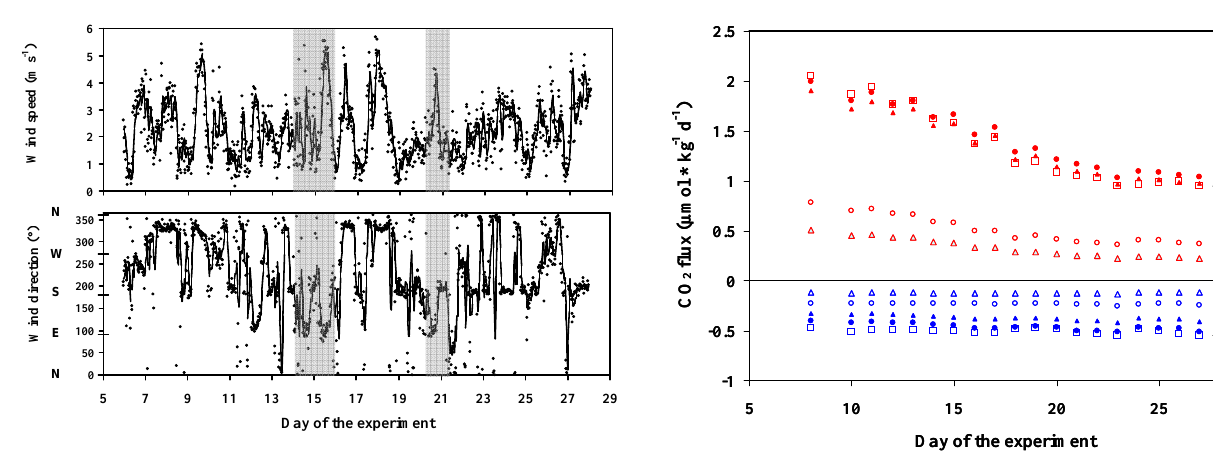
Fig. 6. Wind speed and direction during the course of the exper- iment, measured at 10m height at Bayelva station, Ny Alesund. Waves (up to H 1 / 3 = 0.8m) were observed at the mooring site dur- ing time intervals indicated by shaded areas, when relatively strong Fig. 6 892 wind was blowing along the fjord from southeast. Wind speed and direction during the course of the experiment, measured at 10 m height at 893 Bayelva station, Ny Alesund. Waves (up to H 1/3 = 0.8m) were observed at the mooring site 894 during time intervals indicated by shaded areas, when relatively strong wind was blowing 895 along the fjord from south east. 896